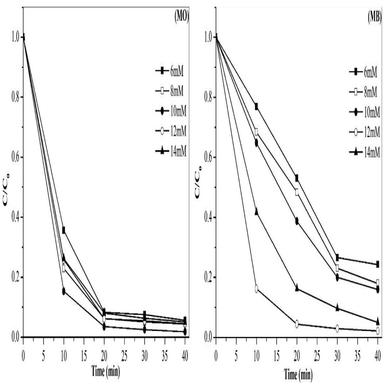
Effect of H2O2 concentration on the degradation of MO and MB. Conditions: dye, 10 mgL1 ; pH, 3 for MO, 3.5 for MB and Catalyst, 0.06 g L1 .